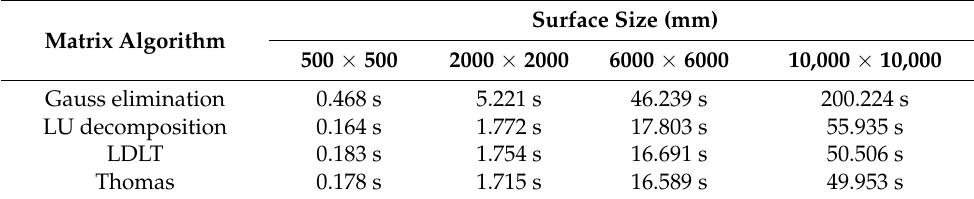
Table 2. Time consumption results of the areal filtering